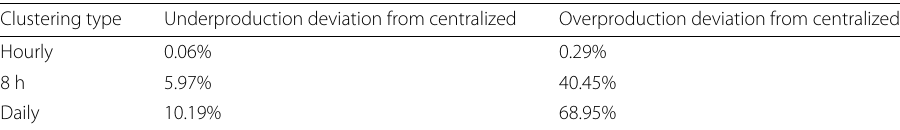
Table 3 Clustering type deviation from centralized